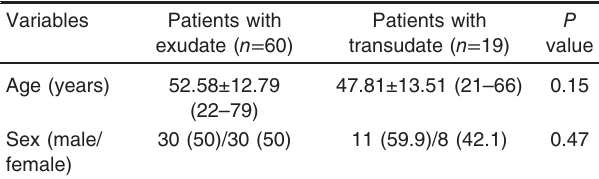
Table 1 Demographic data of the studied patients